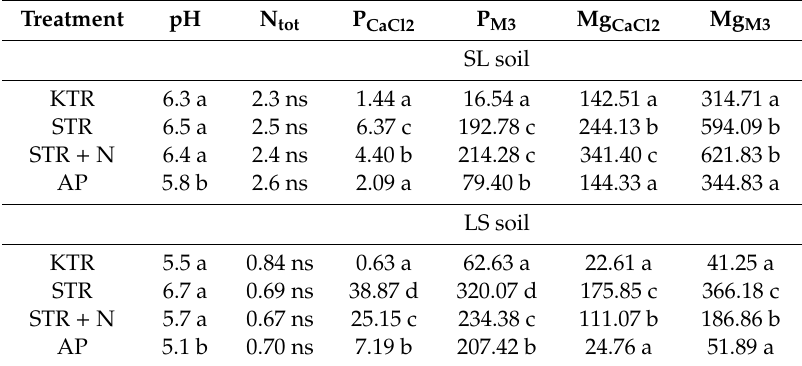
Table 4. Soil pH, content of total nitrogen (g N tot kg − 1 ), and active (mg P CaCl2 kg − 1 ) and available (mg P M3 kg − 1 ) forms of nutrients in SL and LS